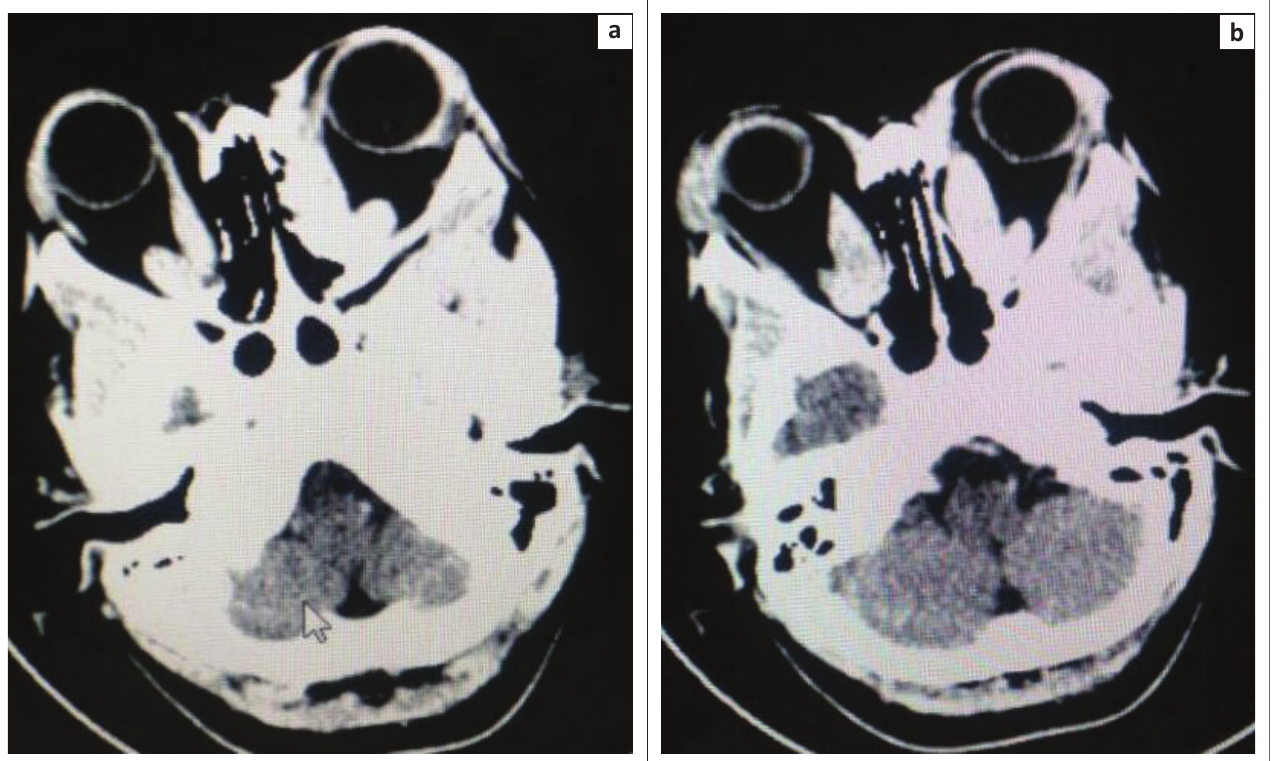
FIGURE 1: Computed tomography showing bulky extraocular muscles with sparing of the muscle